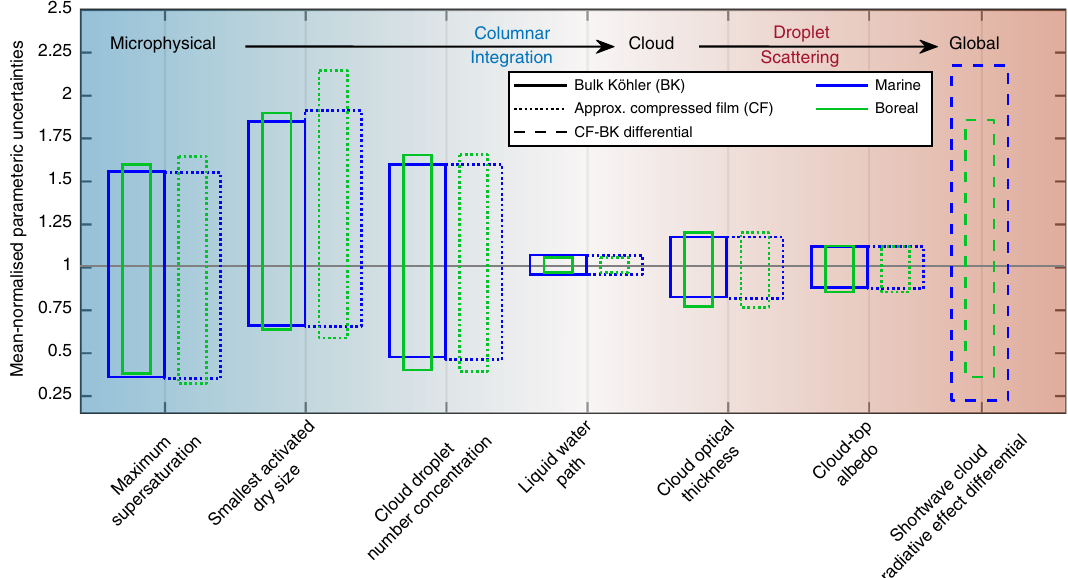
Fig. 5 Normalised parametric uncertainties in parcel model simulated cloud microphysical and optical properties, and estimated surface phase induced short-wave cloud radiative effect (SW-CRE). Mean-normalised parametric uncertainties determined by dividing the 95th (top) and 5th (bottom) percentiles by mean values obtained from model output distributions resulting from simulations initialised with 5000 Latin hypercube sampled 38 parameter combinations from ranges in Table 2. A cloud depth of 200 m is assumed in all cases, and cloud droplet number concentrations statistics are made at cloud top. The SW-CRE differential is estimated by assuming fi xed cloud fractions of 0.7 (marine) and 0.5 (boreal, land proxy) NATURE COMMUNICATIONS| (2019) 10:5214